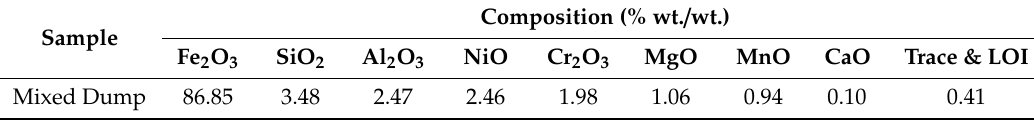
Table 3. Chemical composition of the raw mixed dump sample analyzed through XRF.